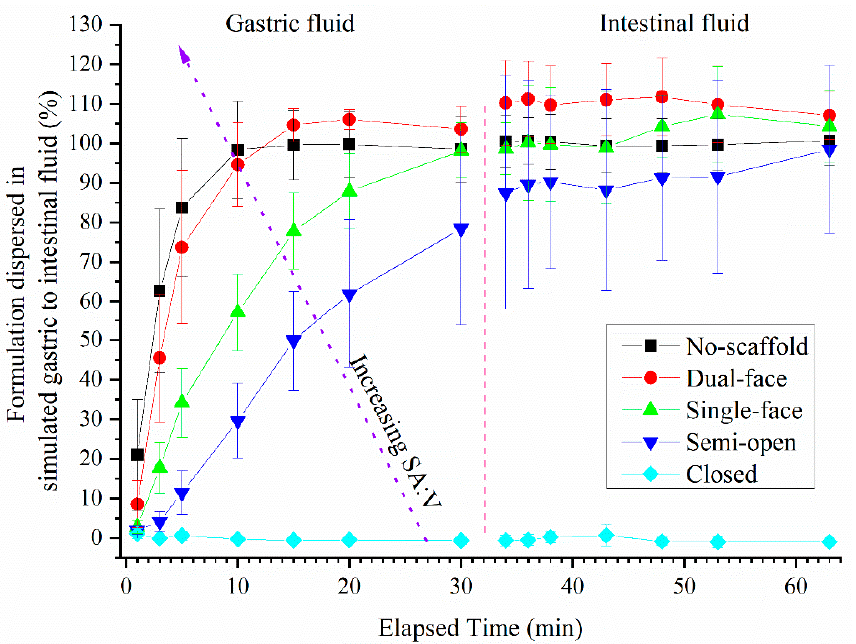
Figure 7. Turbidity of dispersion media resulting from dispersion of fenofibrate-loaded SMEDDS from different single-compartment PLA-based scaffolds (error bars—AVG ± SD, whereby n = 7 for no-scaffold, n = 4 for dual-face and semi-open, n = 3 single-face and closed-type tablets). The dashed red line indicates the transition from gastric to intestinal conditions. The 100% level was determined by full dispersion of a blank SMEDDS. Pellet without any polymer scaffold.